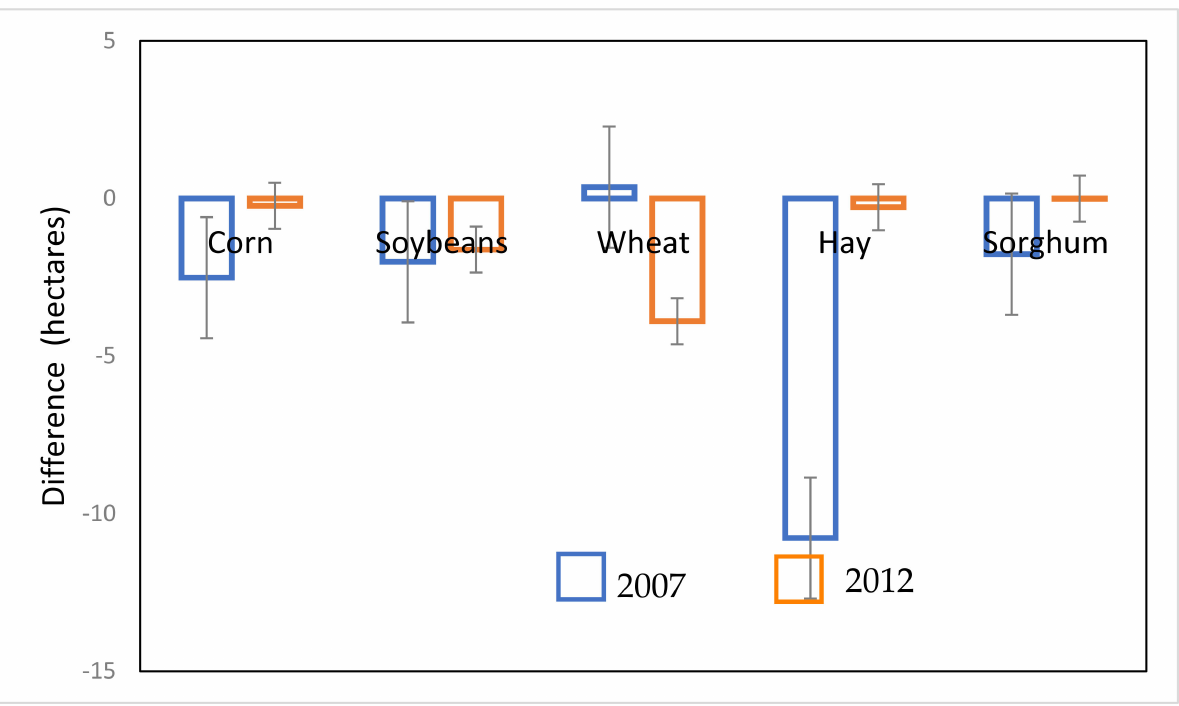
Figure 7. Differences in total cropland area for the top five crops between the estimates from the Cropland Data Layer (CDL) and the reported area in PCHA for the 20 states in 2007 and 2012.3.3. Comparing cropland change in datasets to determine if there is